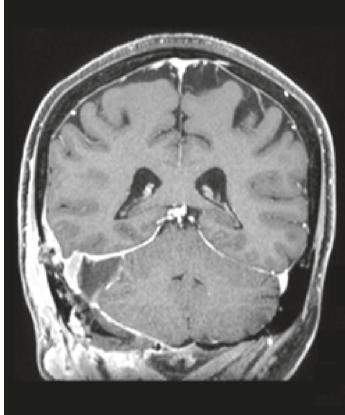
Figure 4: Coronal view of contrast-enhanced MRI scan following